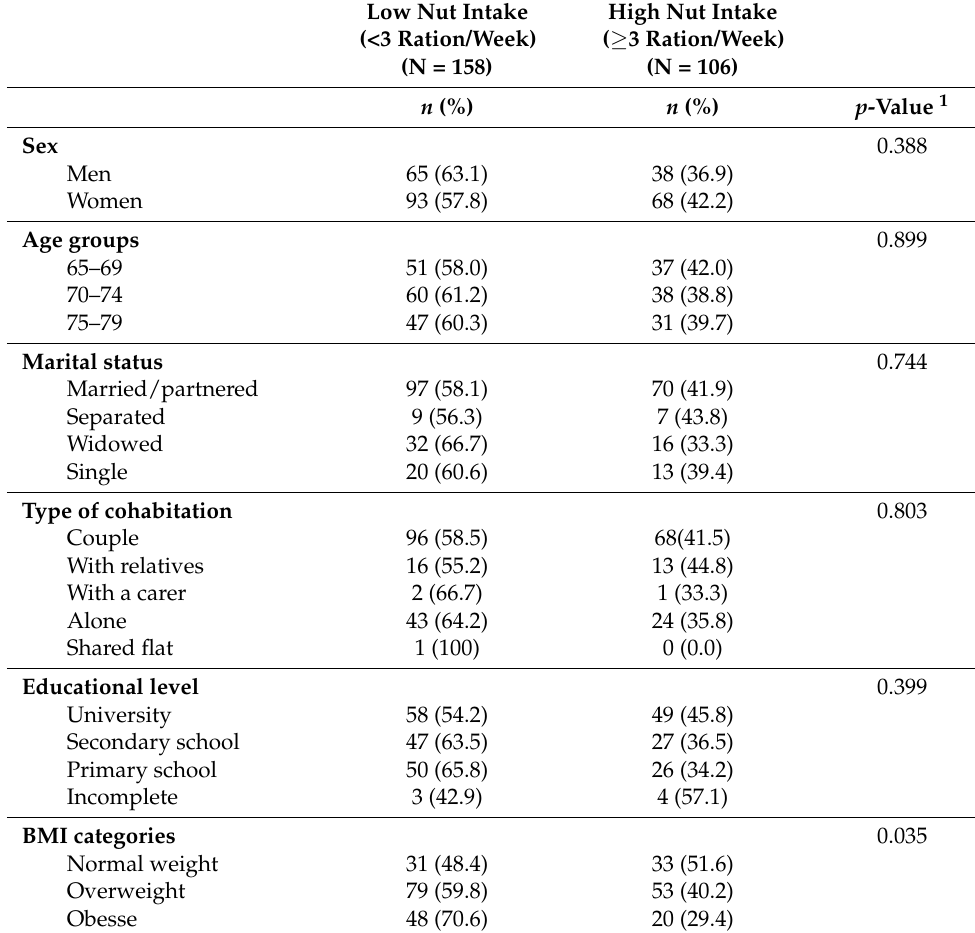
Table 1. Nut consumption by sociodemographic and health-related